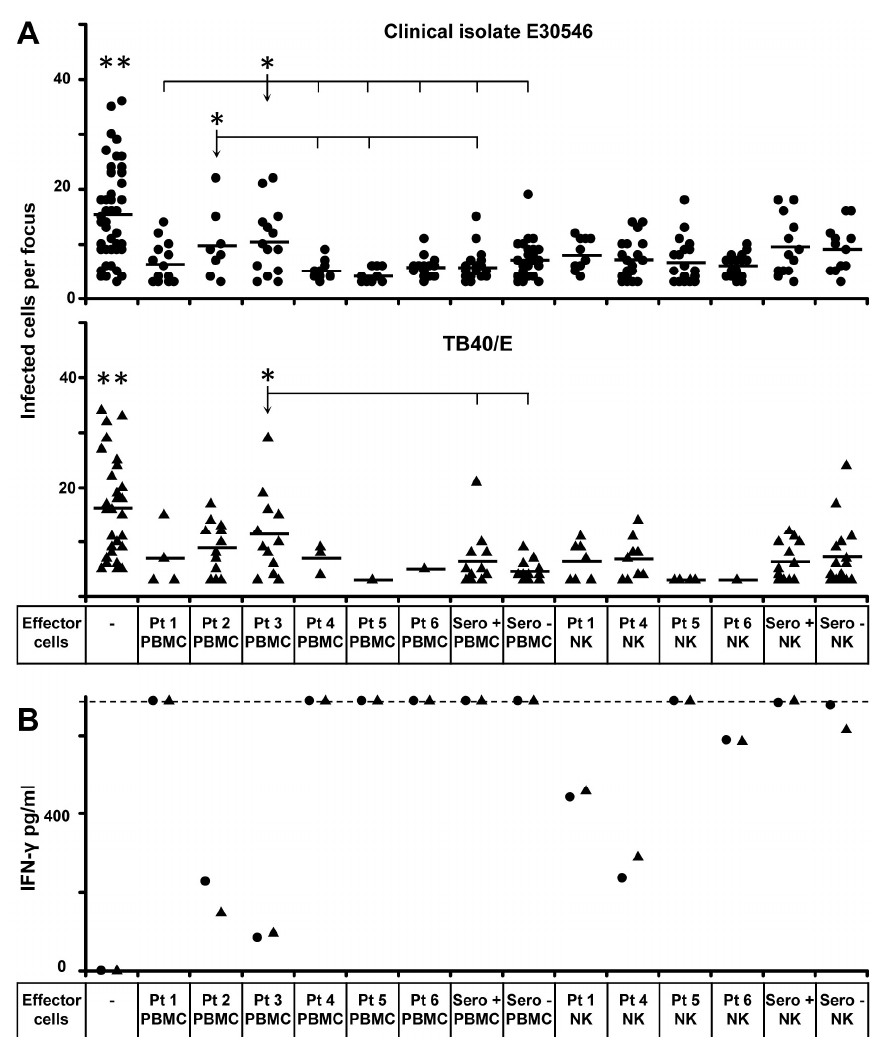
Figure 1. NK cells from SCID patients with defective recombination-activating genes (RAGs) or DCLRE1C inhibit HCMV transmission in fibroblasts. ( A ) Clinical isolate E30546 and TB40 / E infected fibroblasts were co-cultured with 2000-fold uninfected fibroblasts for 3 days. PBMCs or purified NK cells were added to the co-cultures from the beginning. Purified NK cells were added at an E:T ratio of 0.25. The number of PBMCs were adjusted based on the percentage of NK cells to reach an E:T (NK cells:targets) ratio of 0.25. Monolayers were fixed and infected cells were monitored by HCMV IEA staining. Dots represent the number of infected cells per individual focus. Bars indicate mean values. ( B ) The supernatants of each condition were collected after 3 days post co-culture. The concentrations of IFN- γ in supernatants from E30546 infected cultures (circles) or TB40 / E infected cultures (triangles) were tested by ELISA. Dashed line indicates the detection limit. * indicates p < 0.05 to arrow-indicated group, ** indicates p < 0.05 to all other groups.